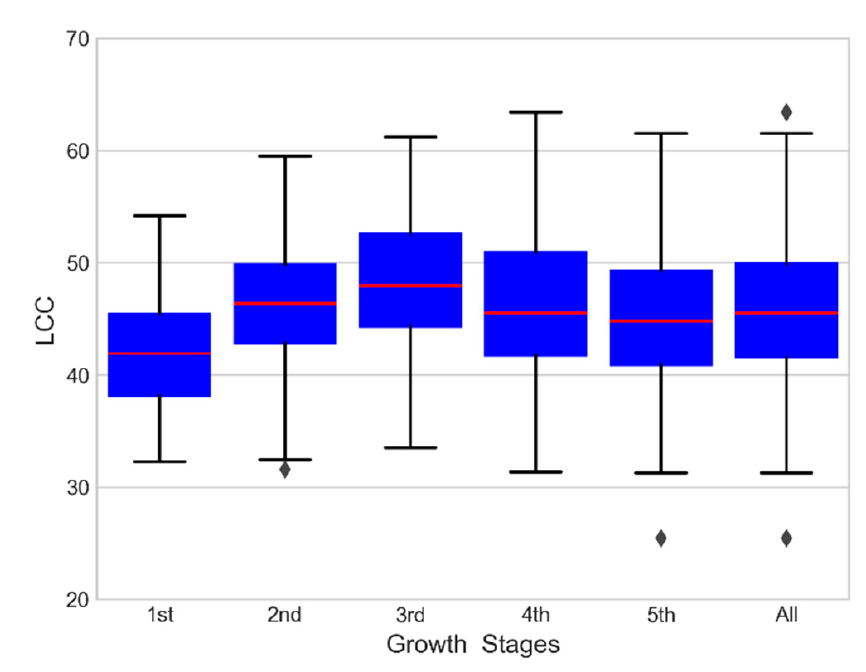
Figure 2. Measured LCC in this study.